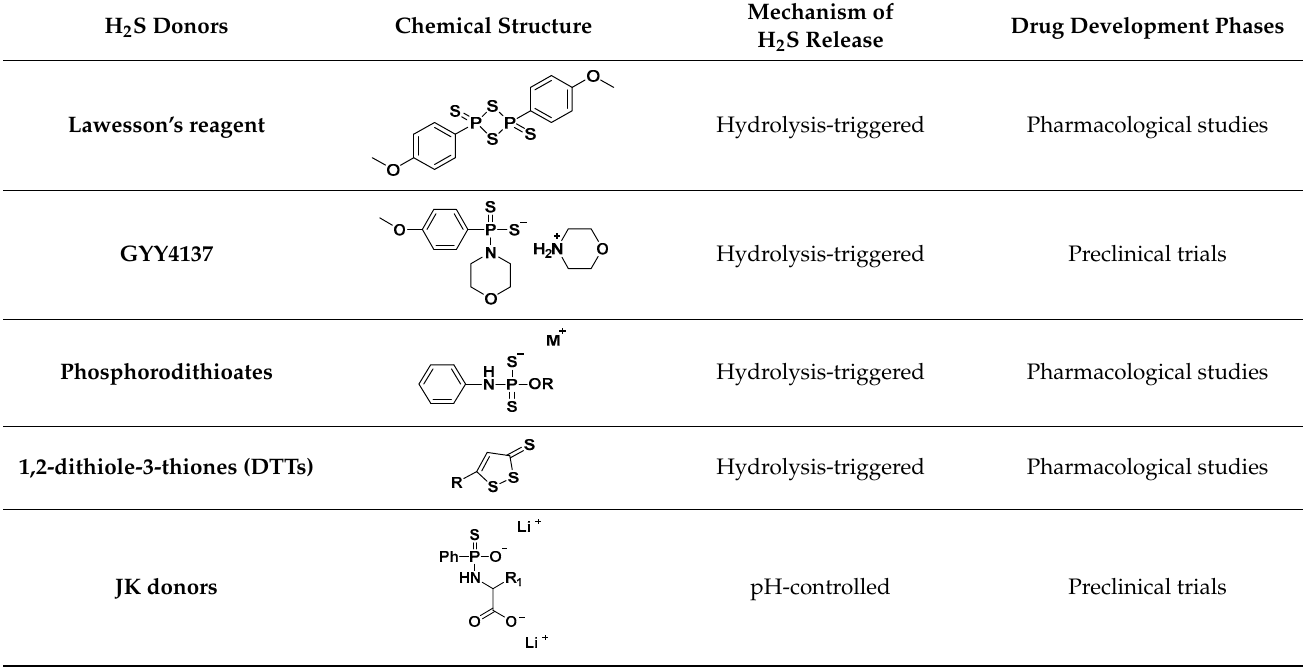
Table 1. H 2 S-releasing molecules in cardiovascular system.